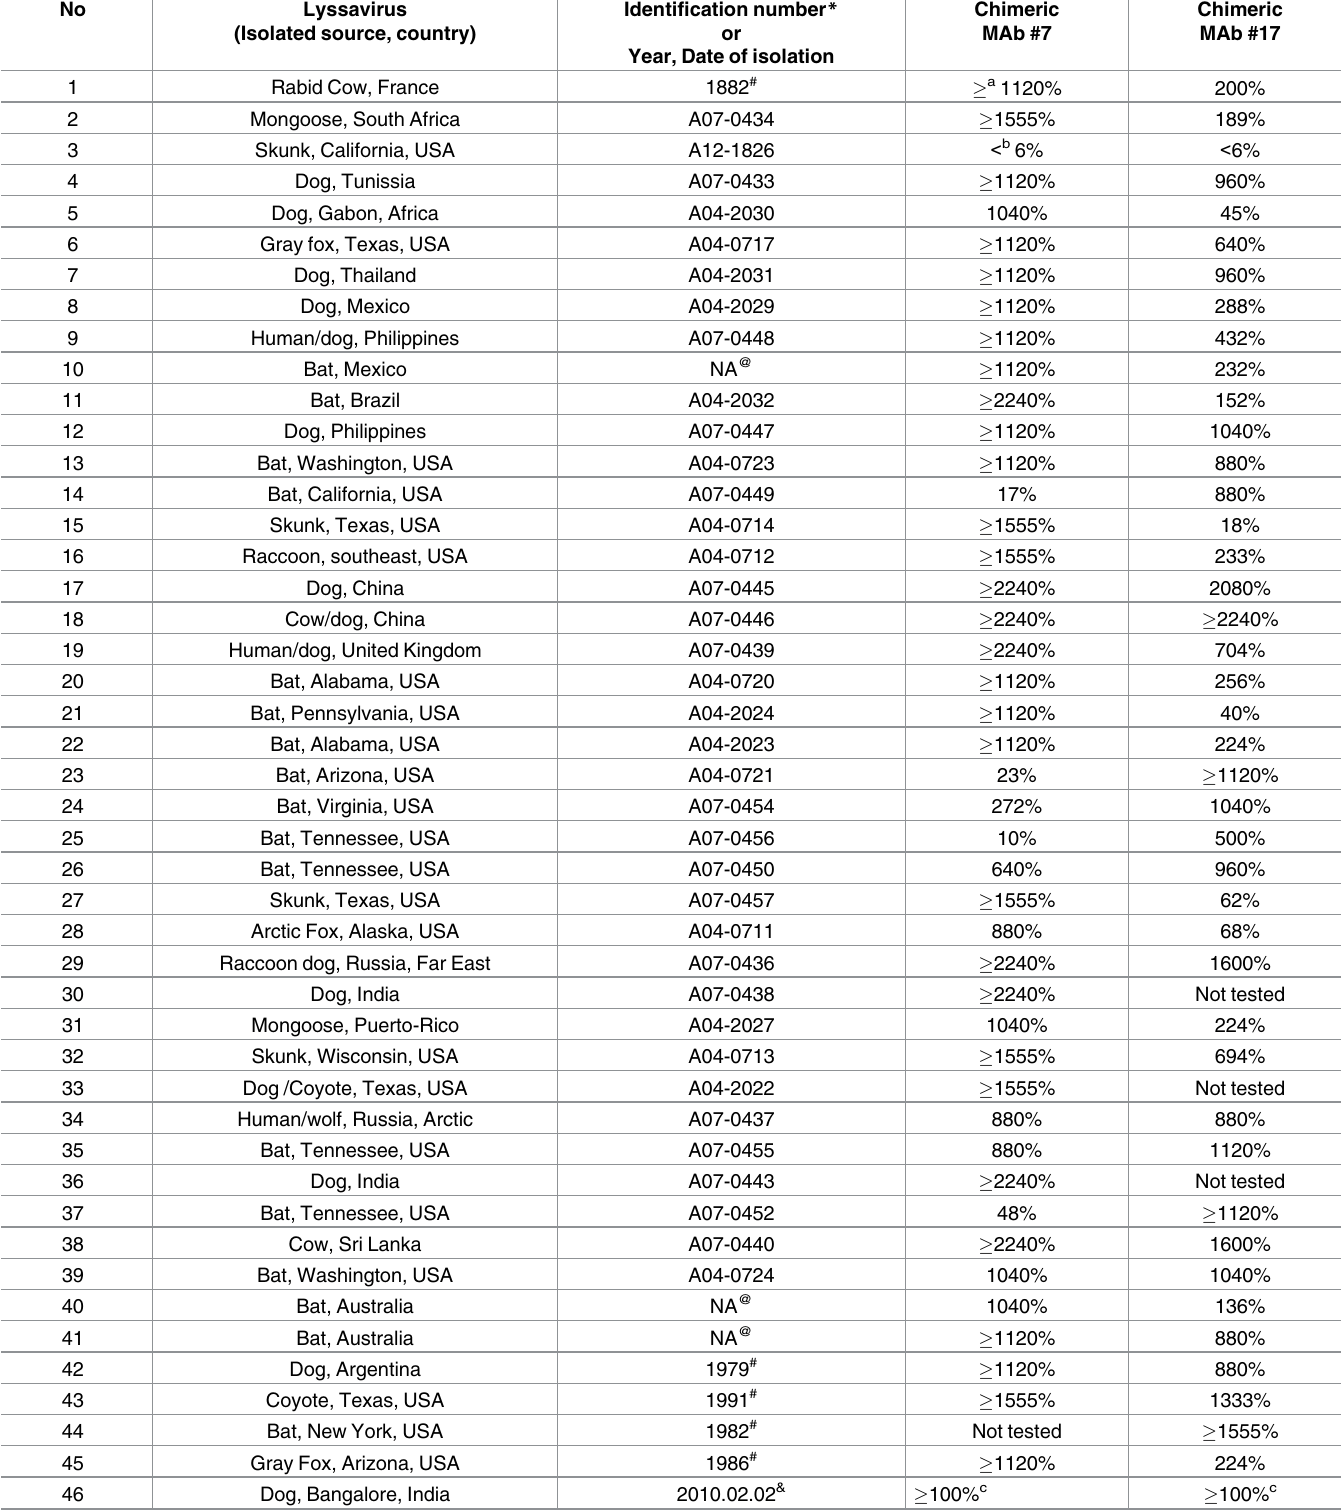
Table 2. Neutralization breadth by chimeric MAbs #7 and 17 against RABV field